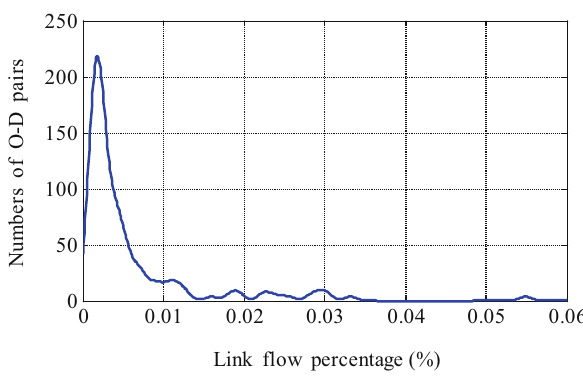
Fig. 14 Probability density distribution of link